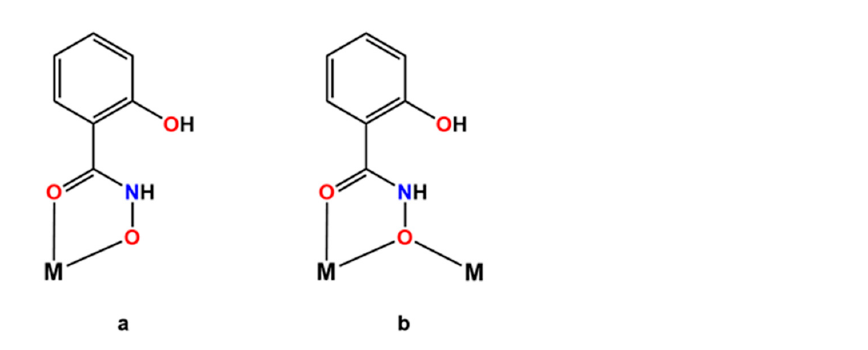
Scheme 2. The two bonding modes of the mono-deprotonated ligand Hdihybe - in the tetranuclear titanium cluster 1 . Chelating ( a ) and bridging-chelating ( b ).